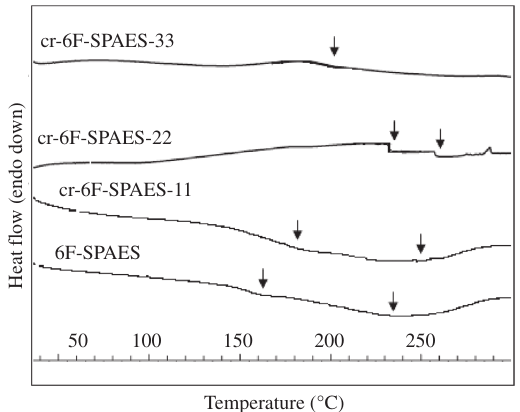
Figure 10: DSC scans of the 6F-SPAES and its crosslinked cr-6F-SPAES